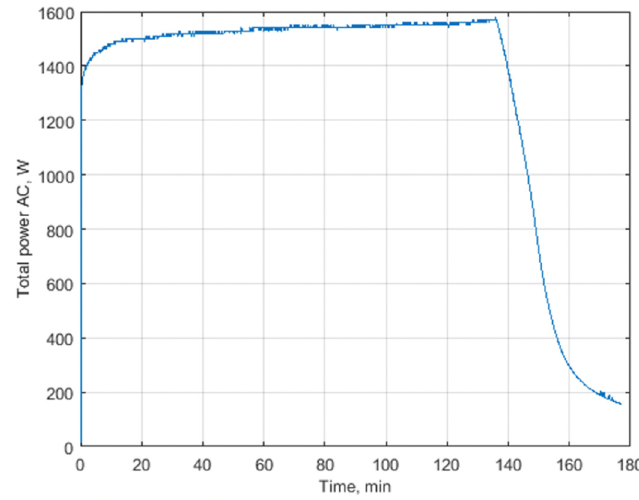
Figure 5. Load graph when charging on the alternating current side.